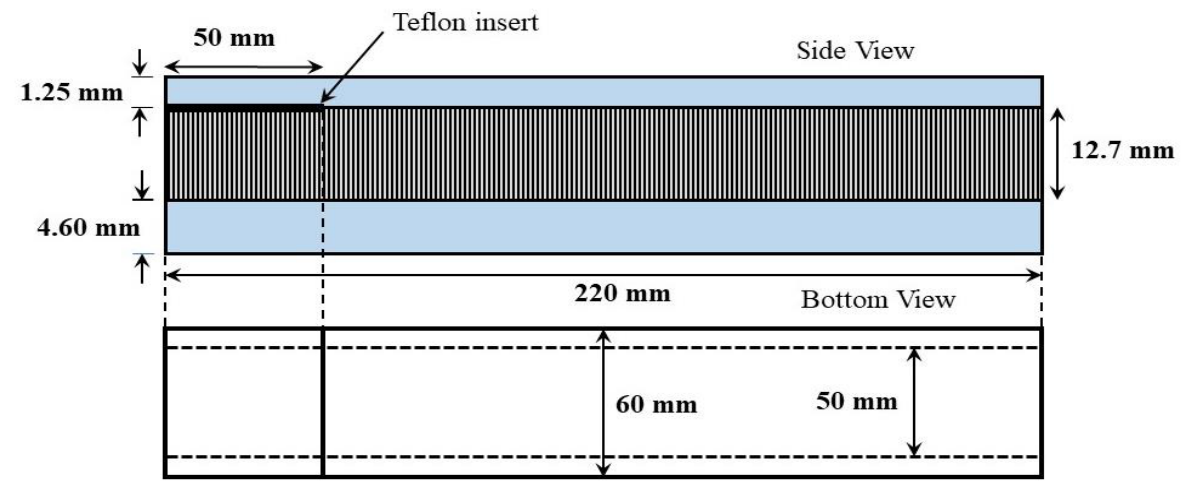
Figure 3. SCB specimen dimensions: (the thickness mentioned in the above images is the average of all the specimens tested). Table 3. Core and Face sheet material properties.